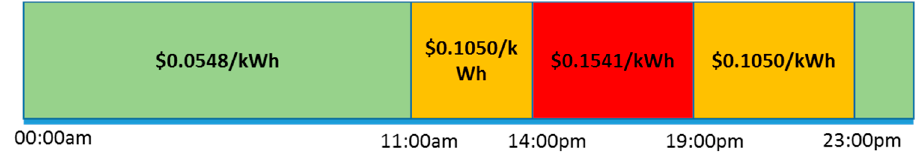
Figure 4. Time of use program (ToU) demand response (DR) signal for a summer day.